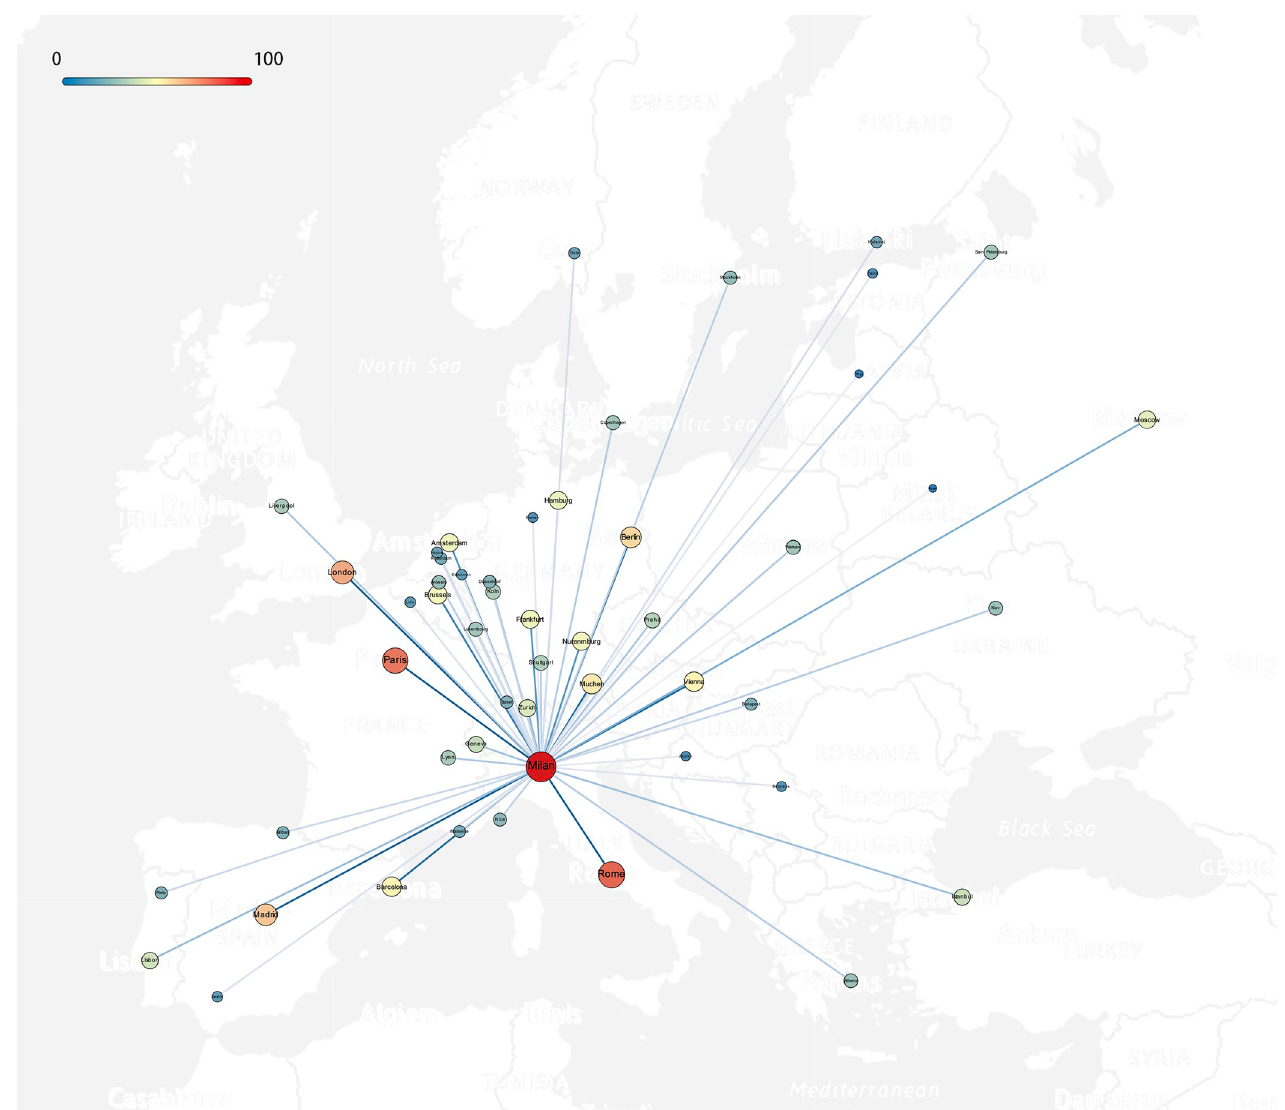
Fig 2. Rough interlocking strength between Milan and major cities in Europe (Base map source: USGS National Map Viewer (public domain)).